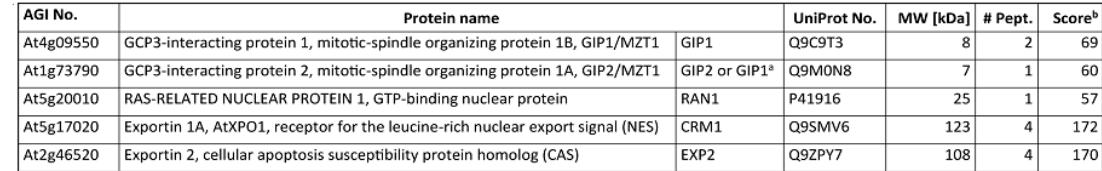
10 of 17 Figure 2. The graphical summary of nuclear γ‐ tubulin interactions and functions in animal and plant cells. Particular sections are based on published data or modified according to the cited references: γ‐ strings [41], γ‐ tubulin fibrils [2], LINC complexes [96,106], lamina interactions and INM integral proteins [77], emerin and Samp1 [100,101], SUN protein interactions [82,97], CRWN (former LINC) proteins [97,121,122], GIP [105], Rae1 and MSL6 [123], kinetochore [22,23], E2F regulation [69,77,124], DNA damage response [61,64,125]. ONM: outer nuclear membrane; INM: inner nuclear membrane; NPC: nuclear pore complex; CEN: centromere. Not to scale. Author Contributions: Methodology and investigation, J.C., H.K., L.T., and P.H.; writing—original draft preparation, supervision, P.B.; writing—review and editing, J.C., H.K., and P.B. Funding: This research was funded by grant P501 15 ‐ 11657S from Grant Agency of the Czech Republic to Pavla Binarová and partially by the Programme for research and mobility support of young researchers from Czech Acad Sci to Hana Kourová. Acknowledgments: We gratefully acknowledge Gabriela Ko č árová for technical assistance and Csaba Koncz (Max Planck Institute, Cologne) for pACT2 cDNA CS library.